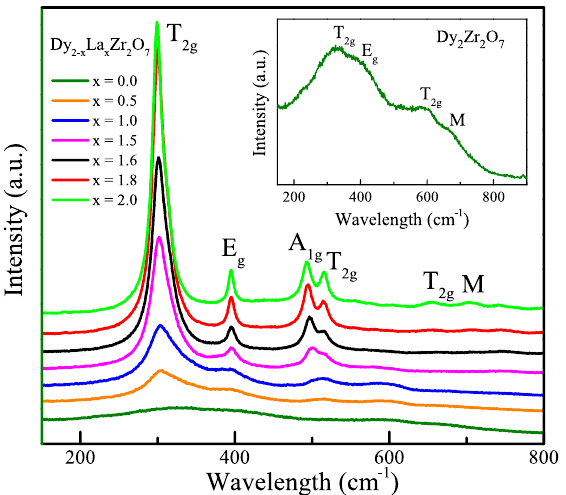
Figure 2. Room temperature Raman spectra of Dy 2 − x La x Zr 2 O 7 ; (0 ≤ x ≤ 2) showing the presence of Raman modes corresponding to pyrochlore structure. Inset: Raman spectra of Dy 2 Zr 2 O 7 .